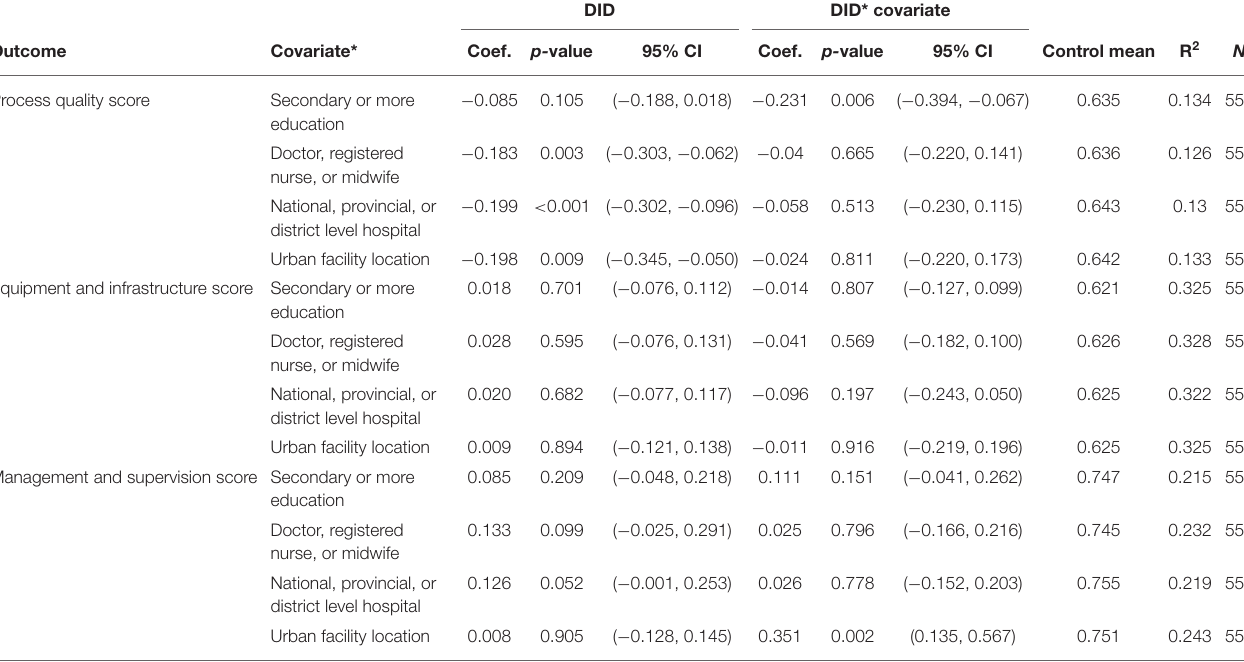
TABLE 13 | Heterogeneity in conflict impact on ANC quality.